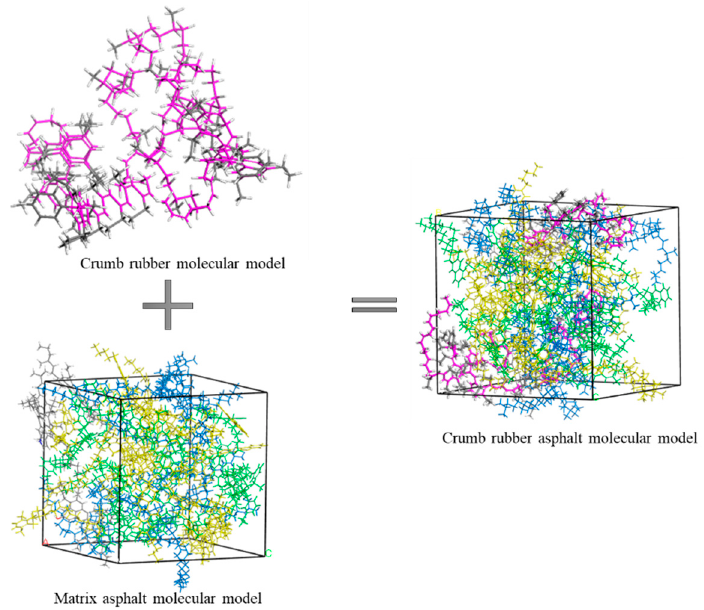
Figure 5. Composition of molecular CR model.